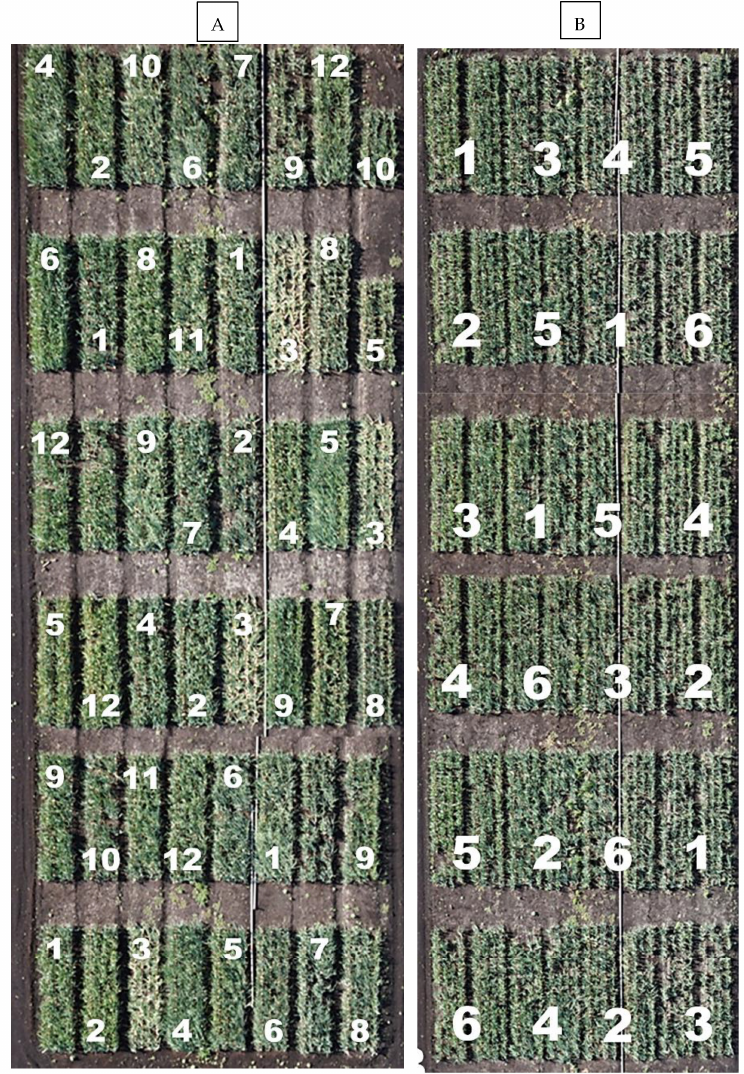
Figure 1. Plot area and treatment numbers (in white) for onion trials at the Holland Marsh, ON in 2015: ( A ) Cultivar trial (each number represents a different cultivar, three replicate blocks shown) and ( B ) Fungicide application-timing trial (each number represents a different treatment, four replicate blocks shown, individual blocks arranged from top to bottom).